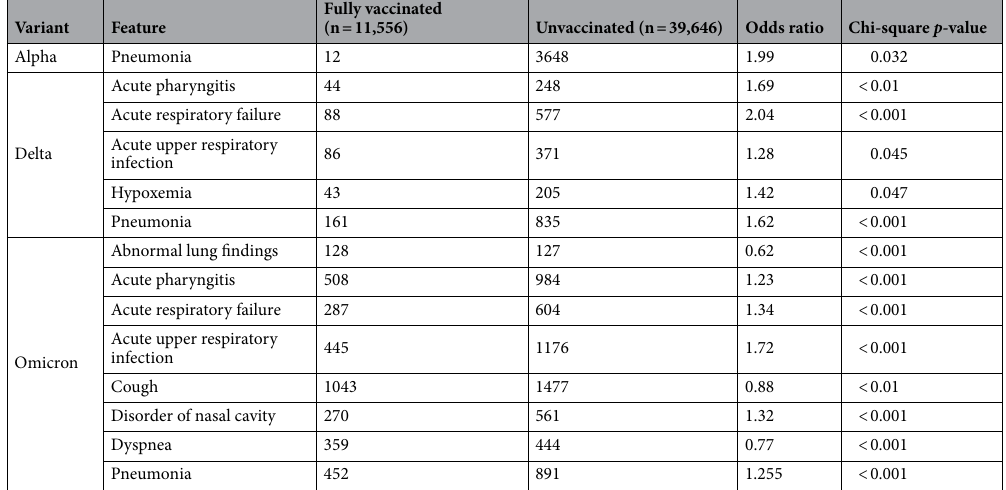
Table 12. Chi-square tests comparing feature significance in fully vaccinated versus unvaccinated individuals across the Alpha, Delta and Omicron waves. p -value < 0.05 is significant.